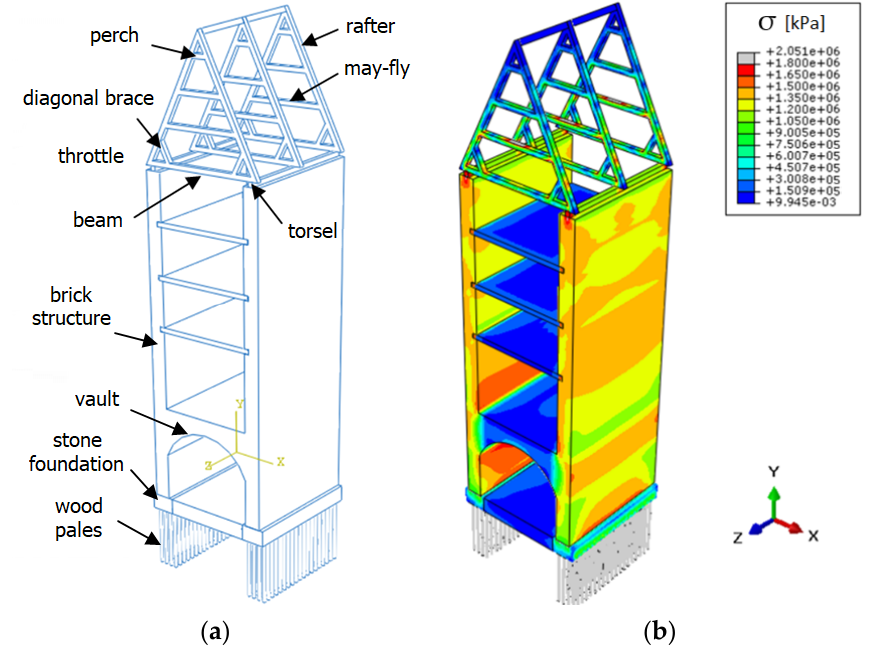
Figure 2. Medieval tenement house in Gdansk: ( a ) numerical model and description of the structural members, ( b ) results of maximum stress maps in (kPa).